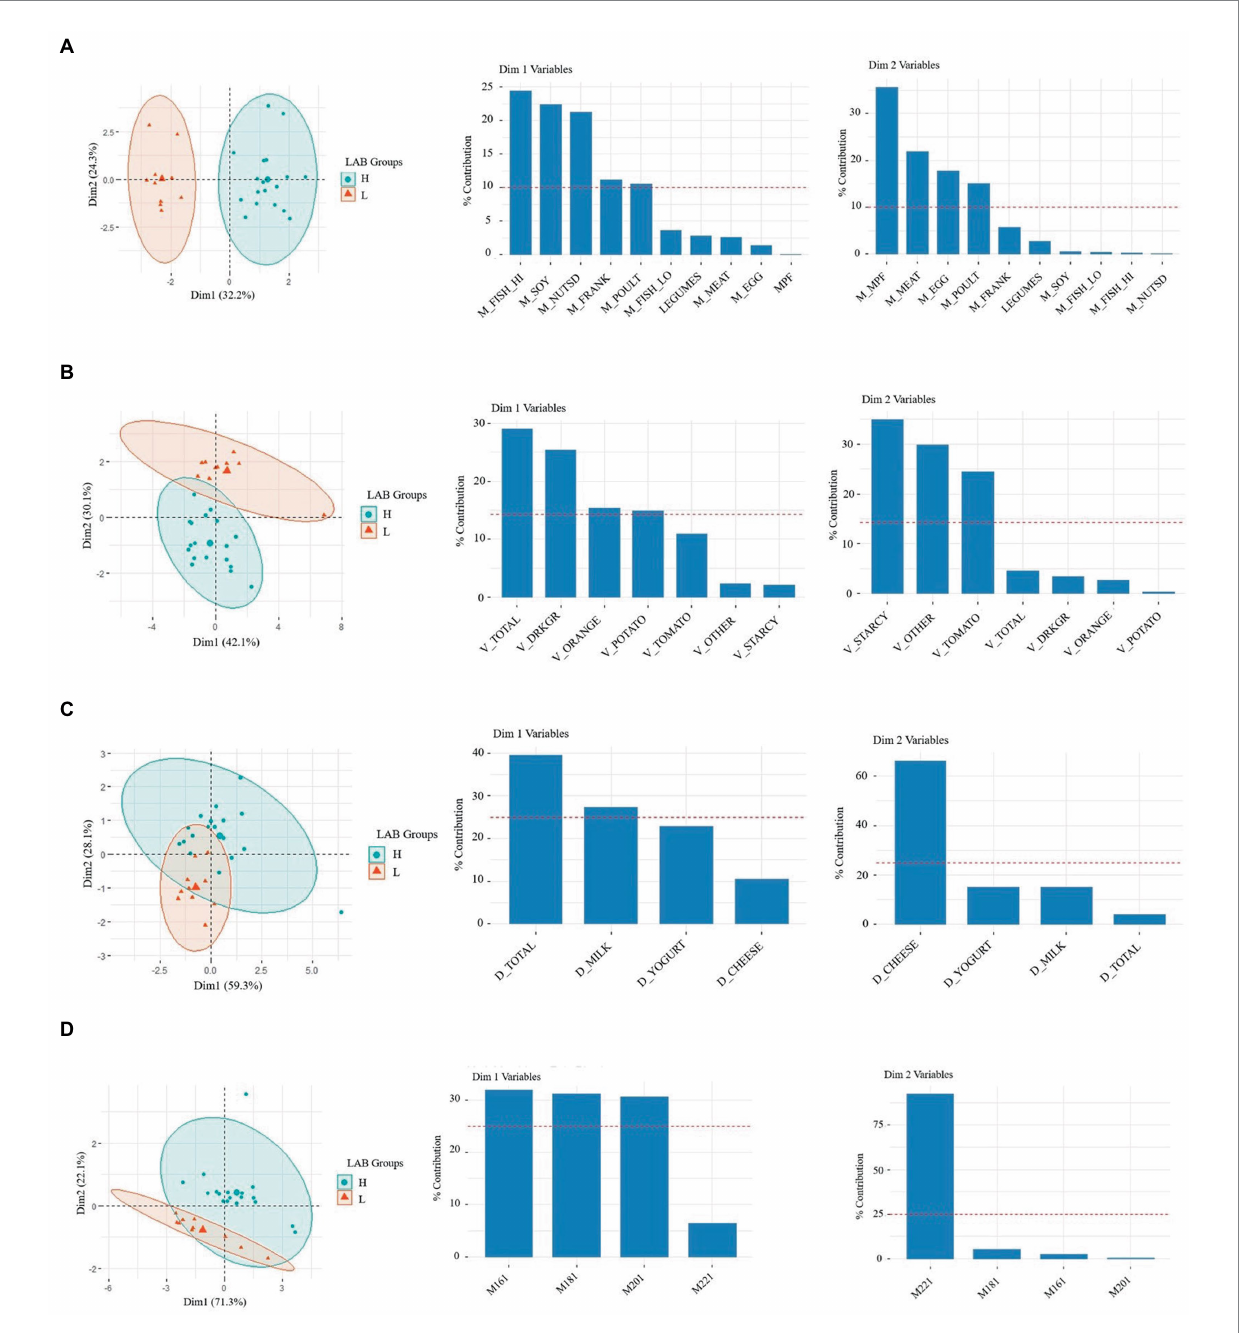
FIGURE 1 Principal component analysis (PCA) of H-LAB and L-LAB groups by habitual intake of (A) meats (oz), (B) vegetables (oz), (C) dairy (oz), and (D) monounsaturated fats (mg). The variables for each of the two dimensions and their % contribution to the variance are given in the eigenvector charts for each PCA